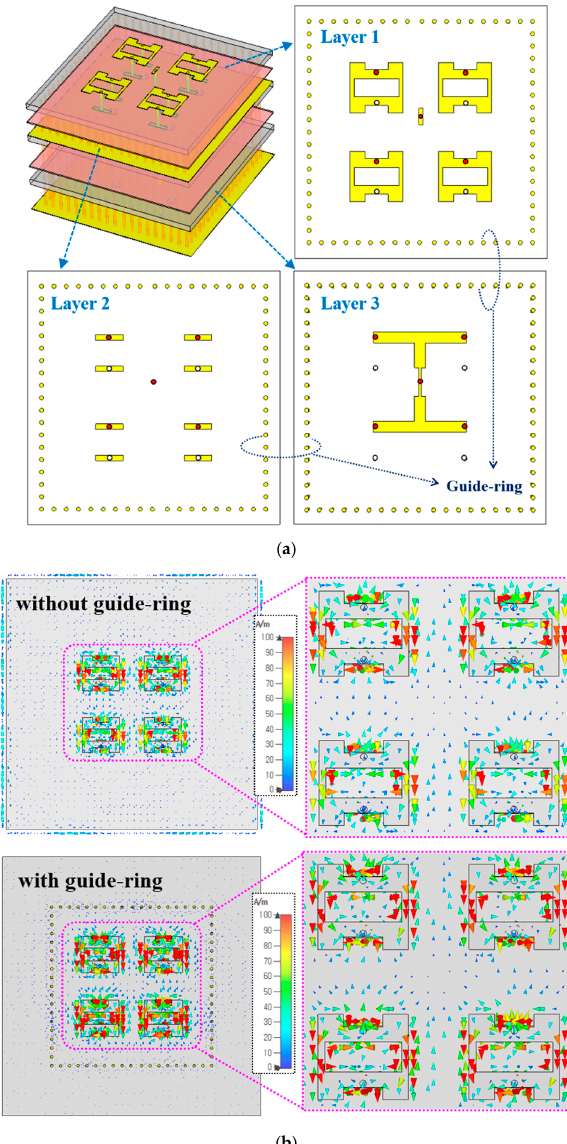
Figure 5. Proposed 2 × 2 array antenna with ( a ) multi-layer view and ( b ) surface current on array elements synchronization by a guide-ring.